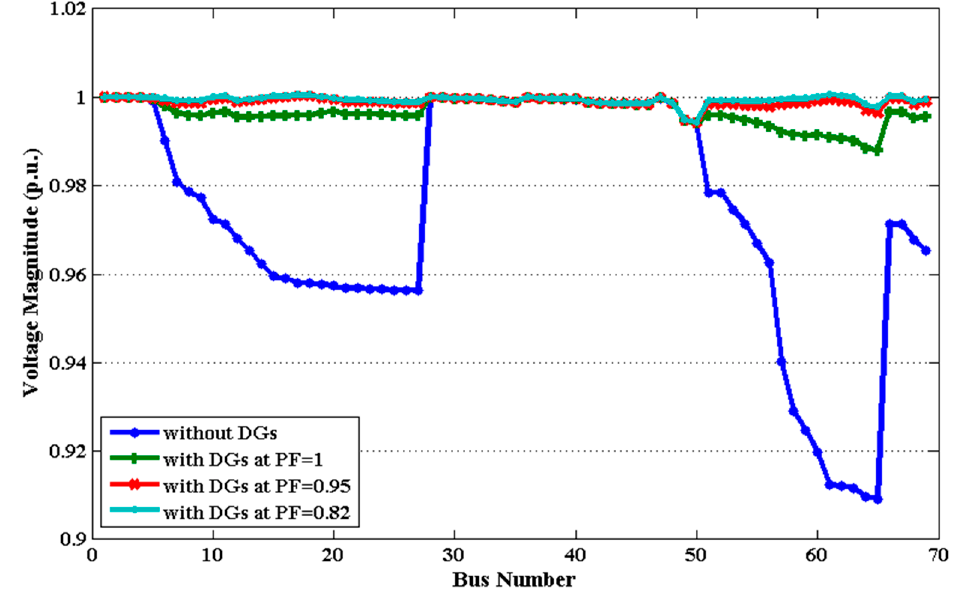
Figure 14. Voltage profile for Case 3 of the IEEE 69-bus system using QODELFA.